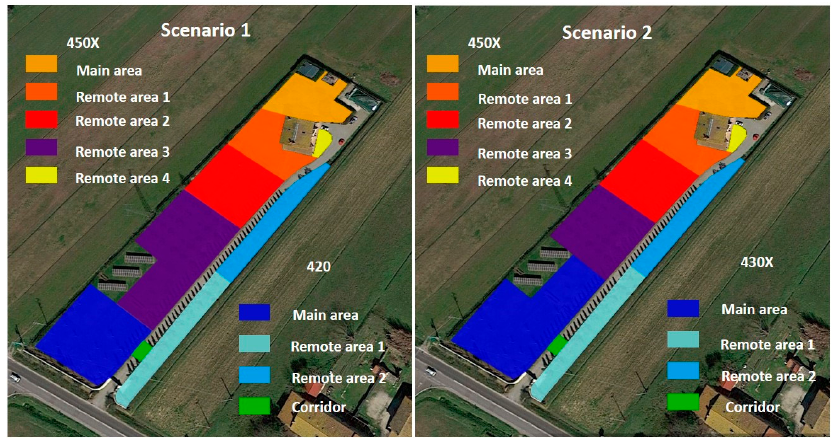
Figure 4. Remote areas of the two scenarios.